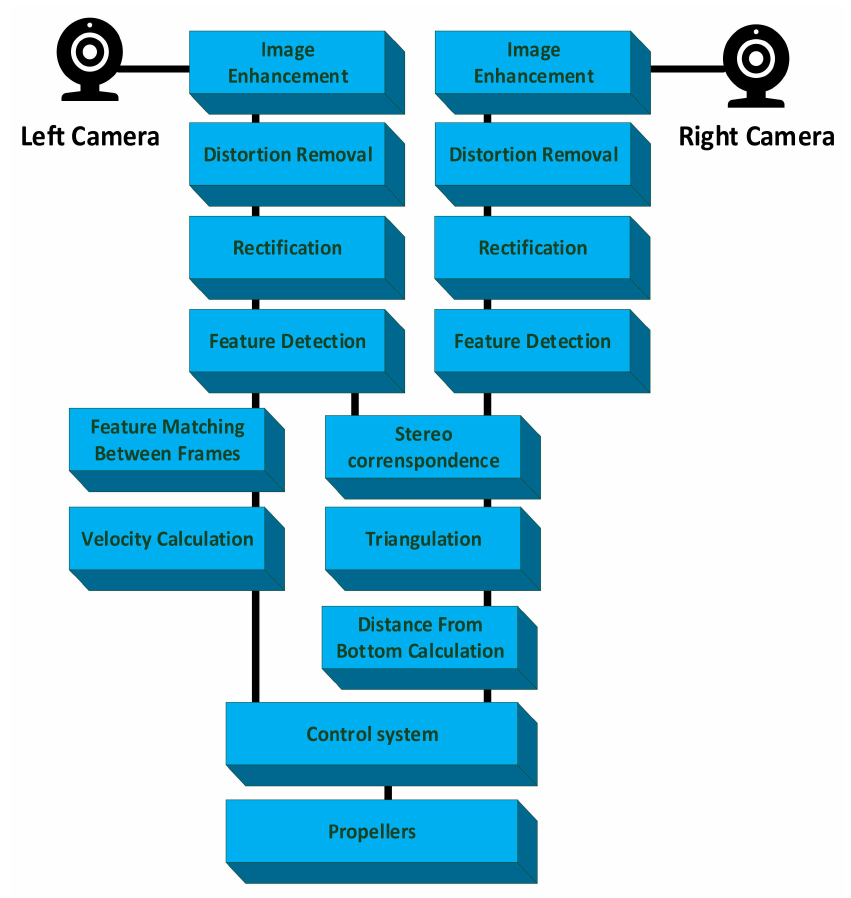
Figure 1. Summary of the developed